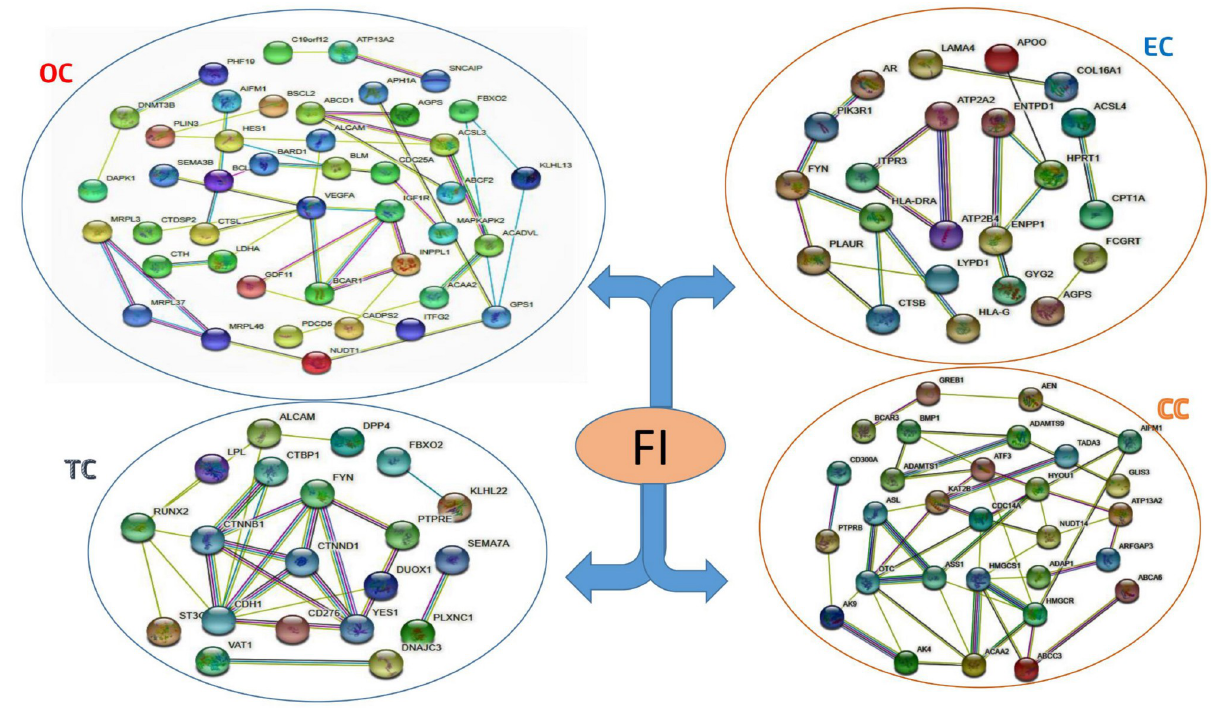
Fig 6. Protein-Protein interaction network for the common paired DEGs between Female Infertility (FI) and Endometrial Cancer (EC), Ovarian Cancer (OC), Cervical Cancer (EC), and Thyroid Cancer (TC). The network nodes depict target proteins, and the edges represent protein-protein